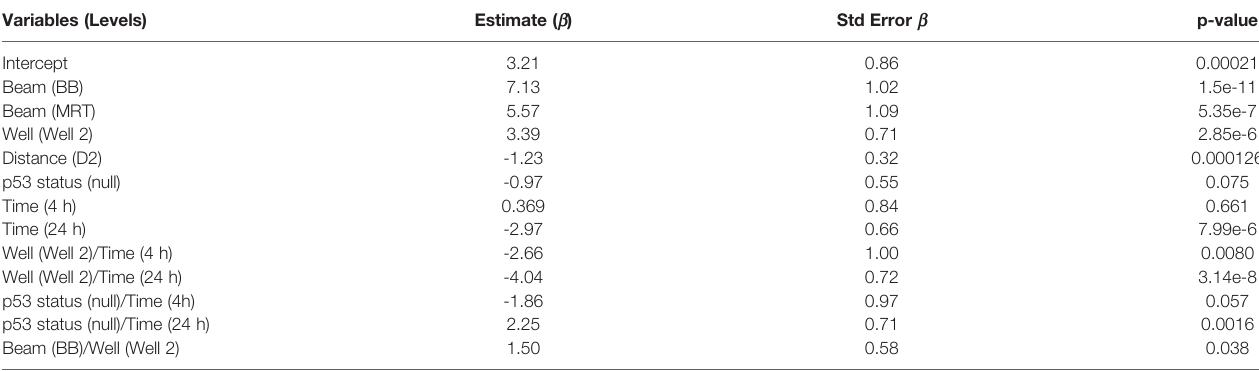
TABLE 2 | Parameter estimates for factors used to predict the response. Variables (Levels) Estimate ( b